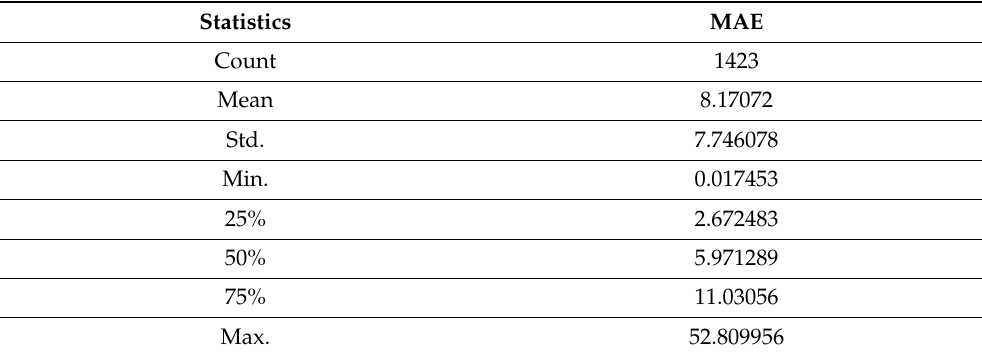
Table 10. Growth status classification results of cabbage from cupping, early heading, and mature stages.